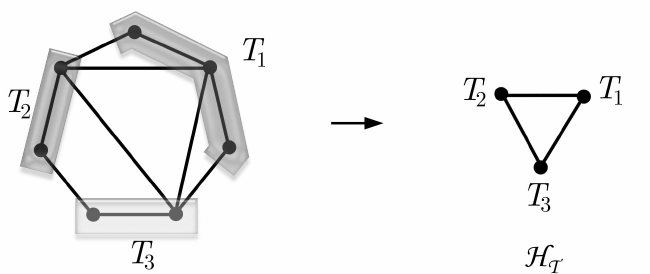
Fig. 2. Forcing trees with no inner edge in their edge set